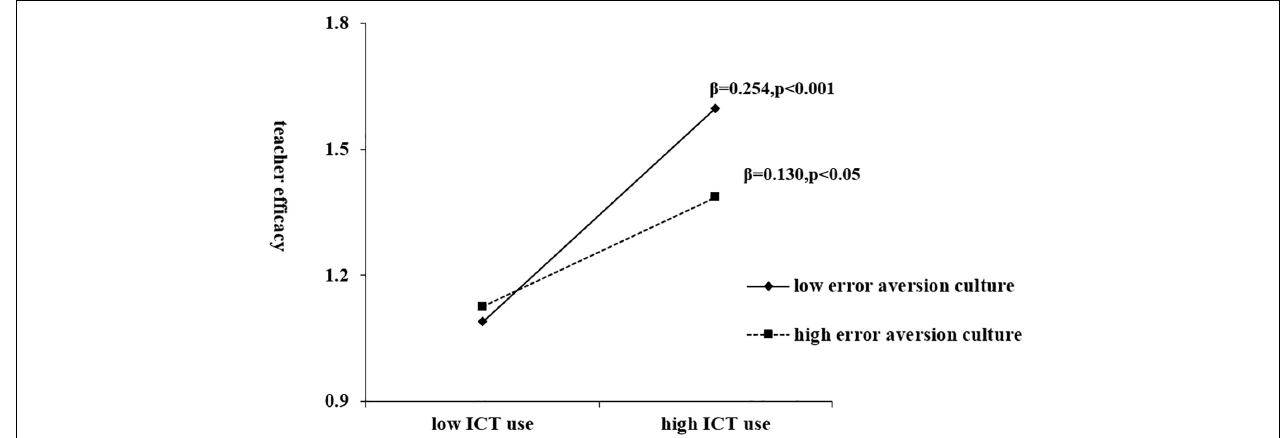
FIGURE 2 | Moderating effect of error aversion